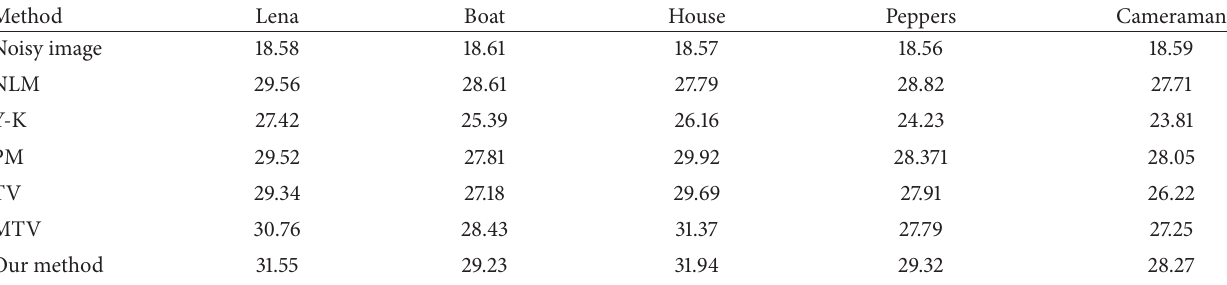
Table 2: PSNR comparison with different methods for noisy image ( 256 × 256